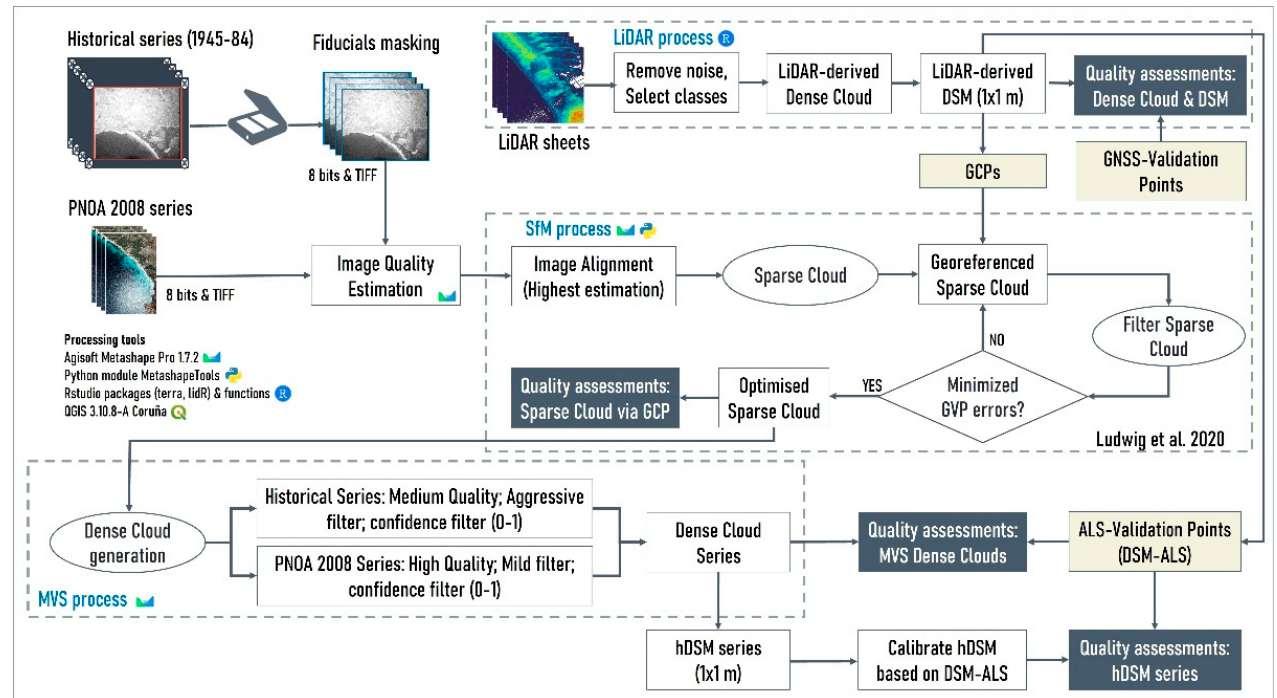
Figure 4. Diagram of the optimized workflow proposed in the study. Yellow boxes depict ground- truth data (GNSS) to validate ALS, GCPs to georeference and validate SfM, and ALS data to validate hDSM. White boxes, diamonds, and circles represent SfM and SVM processing operations and intermediate products. The blue boxes depict the systematic evaluation of the SfM-MVS flow and the final evaluation of the calibrated hDSM.